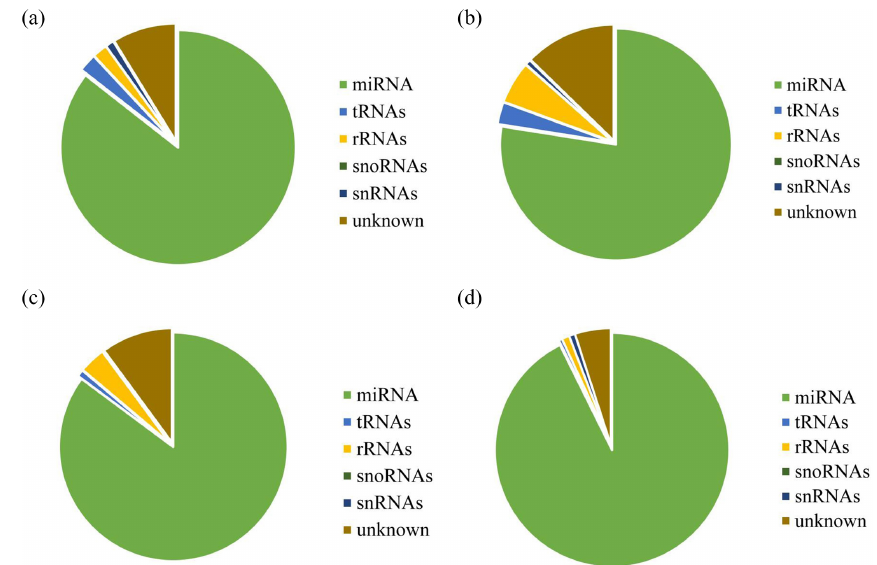
Figure 2. Statistics of the distribution characteristics of non-coding small RNAs between UF and US group. Table 2. Relatively higher abundance of six novel miRNA positions on the genome and its sequence in UF vs. US libraries. Groups miRNA Mature sequence (5 (cid:48) –3 (cid:48) ) Chromosome Free energy localization kcal/mol UFH vs. USH oar-novel-miR-295-5p UGAUUGUCCAAACGCAAUUCUC − 26 . 3 − 26 . 3